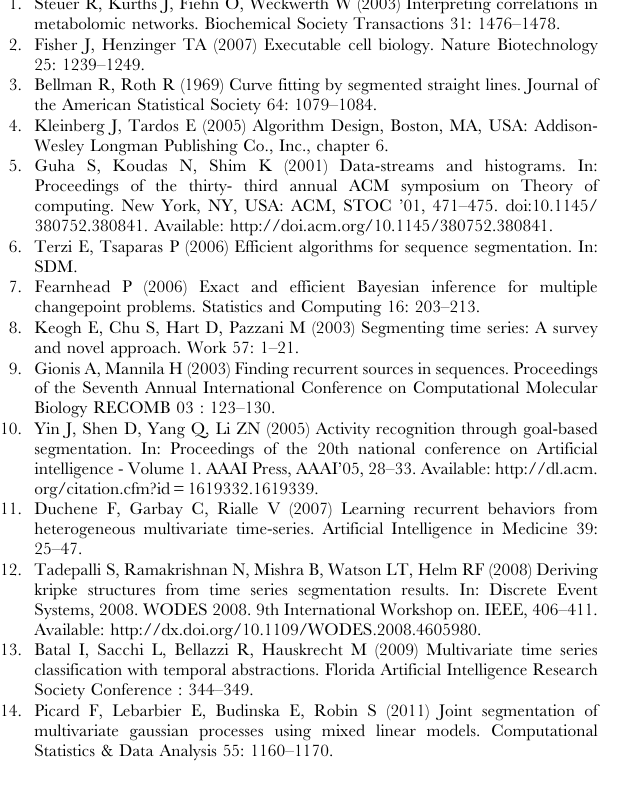
Table S4 Optimal segmentation for data from oxidative stress, induced by hydrogen peroxide (HP), on yeast’s cell cycle. The first part of the table comprises the result of the optimal segmentation for synthetic data based on general longest path algorithm Algorithm 1 (Fig. 3). The second and the third parts show the results based on penalized longest path algorithm using number of segments and distribution of length of the segments to calculate the penalty of a path, respectively. The lower part contains the result based on the method of